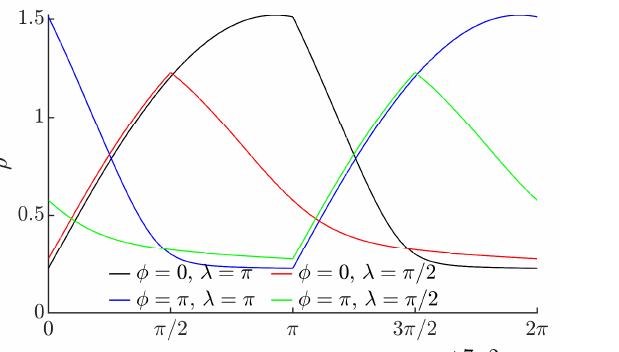
In a range of λ up to approximately 3 π /2, the average nondimensional velocity The influence of the intrinsic system parameters ( λ , ϕ , μ 0 , γ , ⟨ μ m ⟩ / μ 0 ) on the nondi- (cid:104) ϑ (cid:105) increases when λ increases due to the increasing asymmetry of frictional conditions (Figure 8a). When the maximum of (cid:104) ϑ (cid:105) is reached, a further increase in λ results in a decrease in the average nondimensional velocity (cid:104) ϑ (cid:105) due to the decreasing asymmetry of fictional conditions in this range of such high values of λ